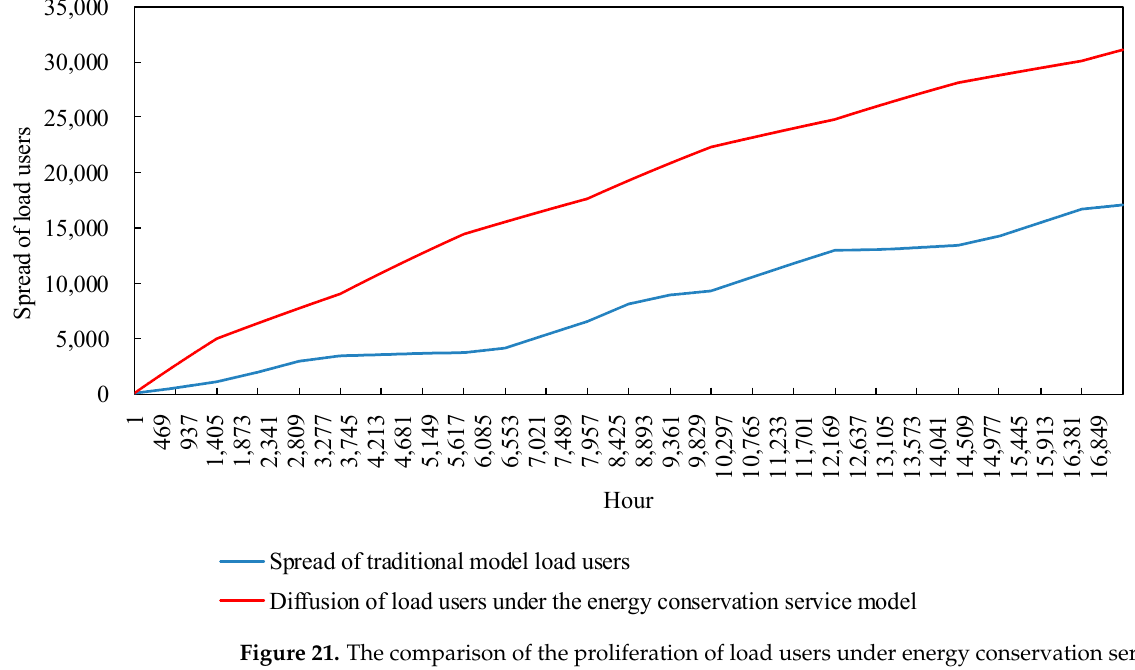
Figure 21. The comparison of the proliferation of load users under energy conservation services.